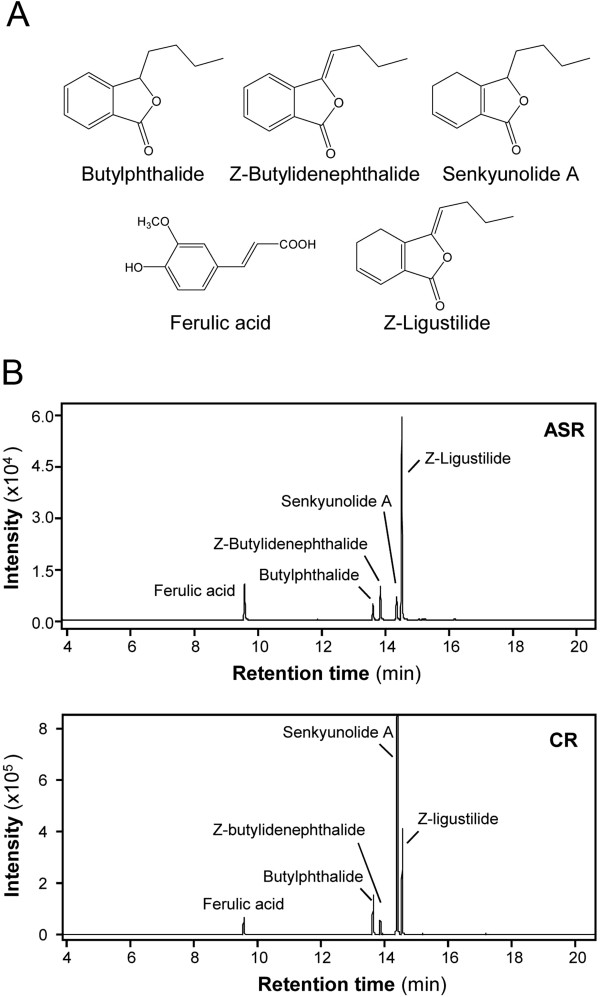
GC-MS/MS MRM chromatograms of extracts from ASR and CR. (A) Chemical structures of ferulic acid, butylphthalide, Z-butylidenephthalide, senkyunolide A and Z-ligustilide. (B) GC-MS/MS MRM chromatograms of ethyl acetate extracts of ASR and CR. Aliquots of 1 L were injected. The information for each peak is indicated. Representative chromatograms are shown (n=3).